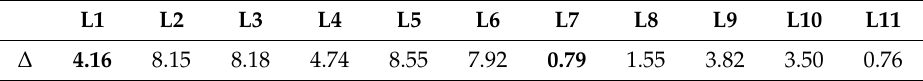
Table 7. Mahalanobis Distances Computed for the Association of Corner L12 of Figure 12. L1 L2